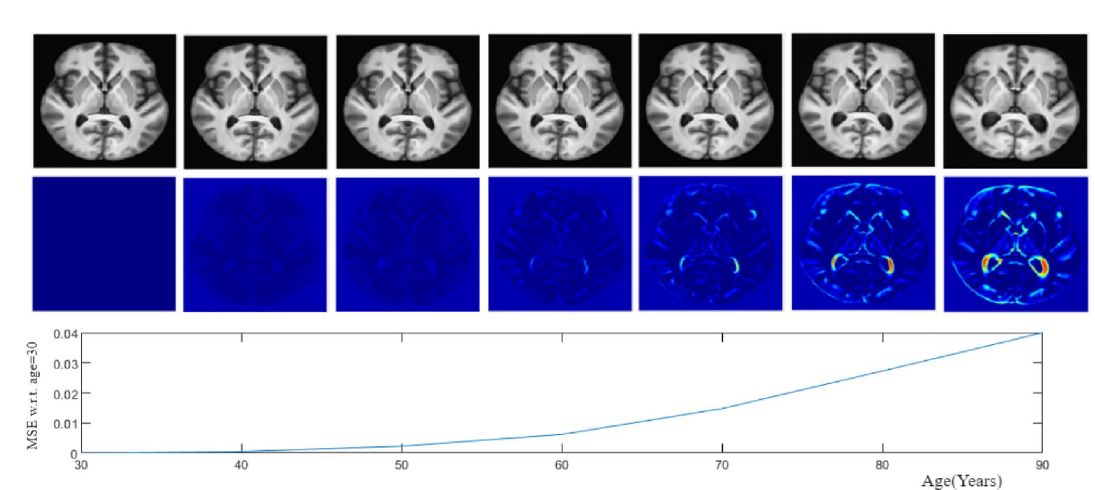
Figure 4. The aging model computed with Neurodev and BRAINS datasets. Sample forward and backward deformations are shown along with the function γ .